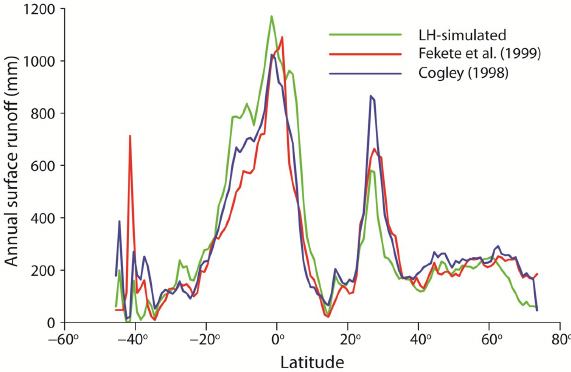
Fig. 11. Estimates of long-term mean annual surface runoff (mm), aggregated into 1-degree latitude zones. LH-simulated data are 30- yr (1961–1990) long-term mean. The Cogley (1998) runoff data were at 1-degree land grid, and Fekete et al. (1999) runoff data were at 0.5-degree land